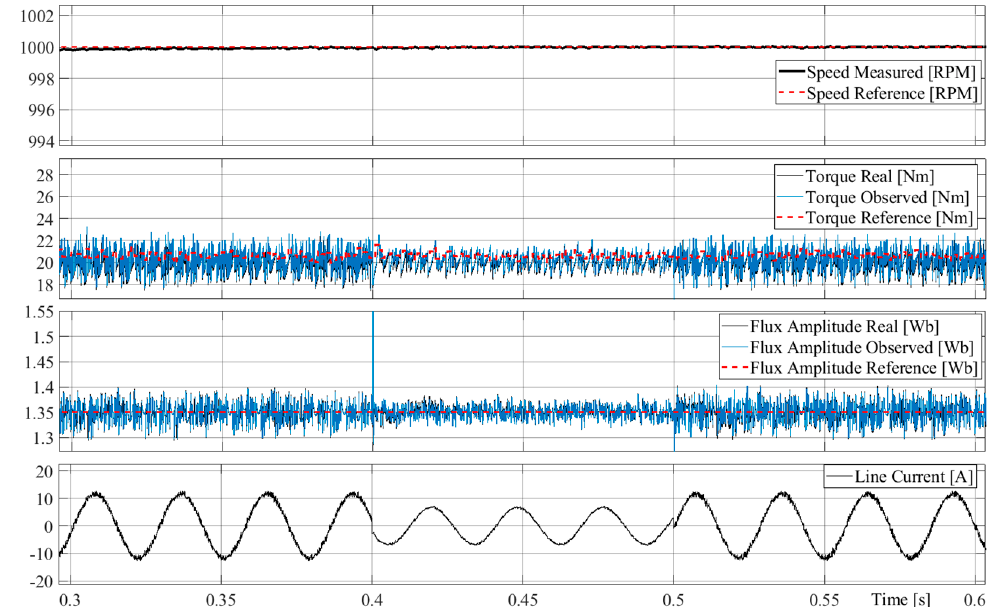
Figure 10. Online change of the winding topology both in the motor model and control model—delta (0.3–0.4 s), star (0.4–0.5 s), delta (0.5–0.6 s).